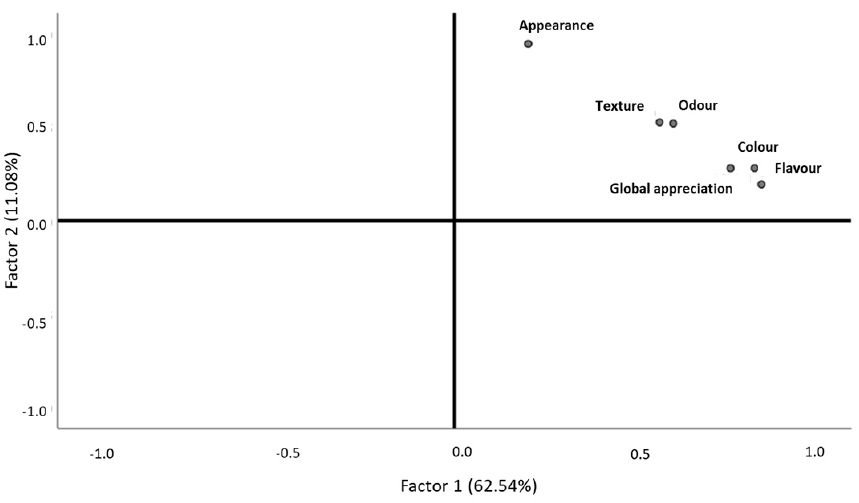
Figure 7. Behavior of fried boarfish descriptors, according to consumer classifications. Table 7. Rotated component matrix for each fried boarfish descriptor.